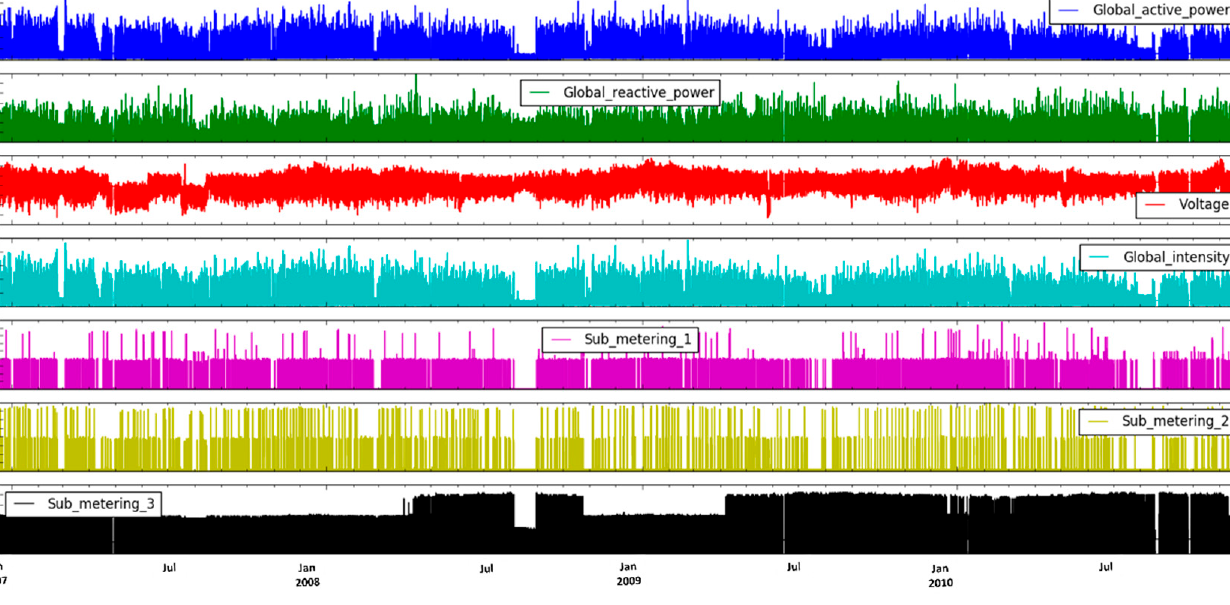
Figure 6. Visual representation of each variable used in household power consumption dataset in minute resolutions. We found that there are missing values present in the years 2007, 2009, and 2010. A decreasing trend was observed each year from July to August, while an increasing trend was seen in the month of September.